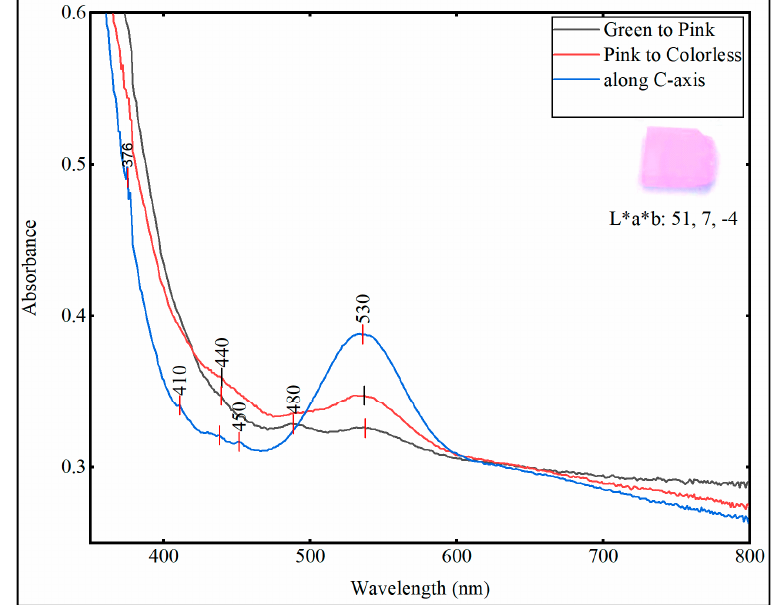
Figure 7. All kunzite samples (K-01 to K-05) show the absorbance peaks at the same wavelengths, with little variation in peak intensity, therefore only one spectrum is taken here for explanation. The spectra were taken in three different optical directions by using gemmological calcite dichroscope and they are marked as: ‘green to pink’, ‘pink to colorless’ and ‘along C-axis’. Color coordinates (CIE L*a*b) were taken by using uvwinlab\meth900 and D65 illuminant in transmission mode.